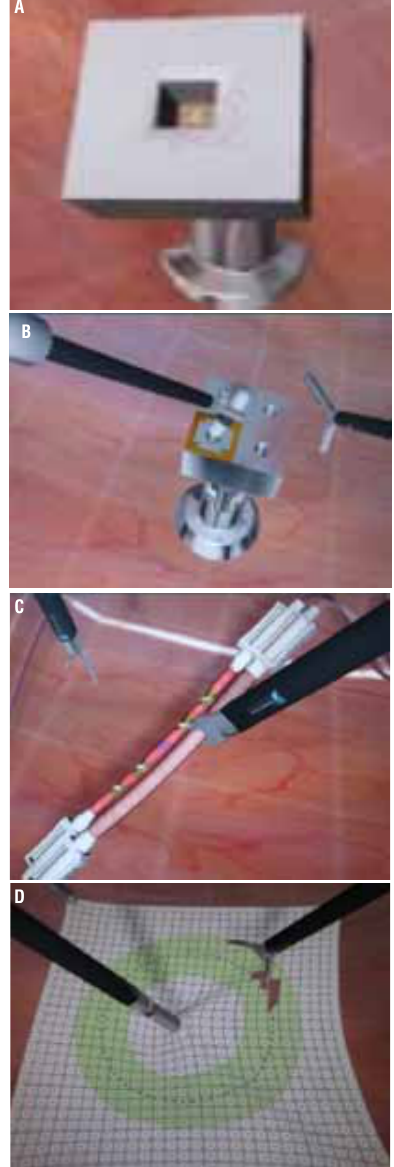
Figure 2 -The students were submitted to simulator training sessions starting at level 1 (Immersion Lap vR, san Jose, CA), including sequentially camera handling (a), peg and transfer (b), clipping (c) and cutting (d). Each student trained twice a week until 10 sessions were completed. The score indexes were registered and